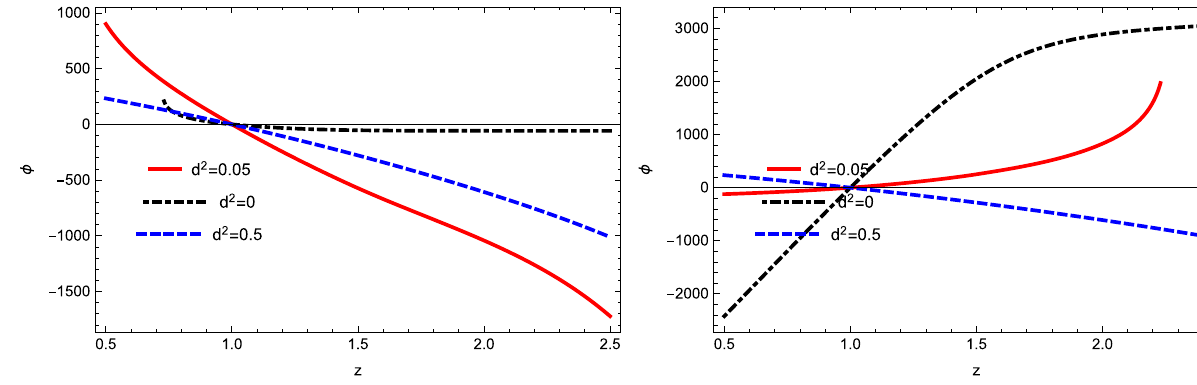
Fig. 11 Plot of φ verses z for u = 1 and u = 2 . 002 for K-essence scalar field model